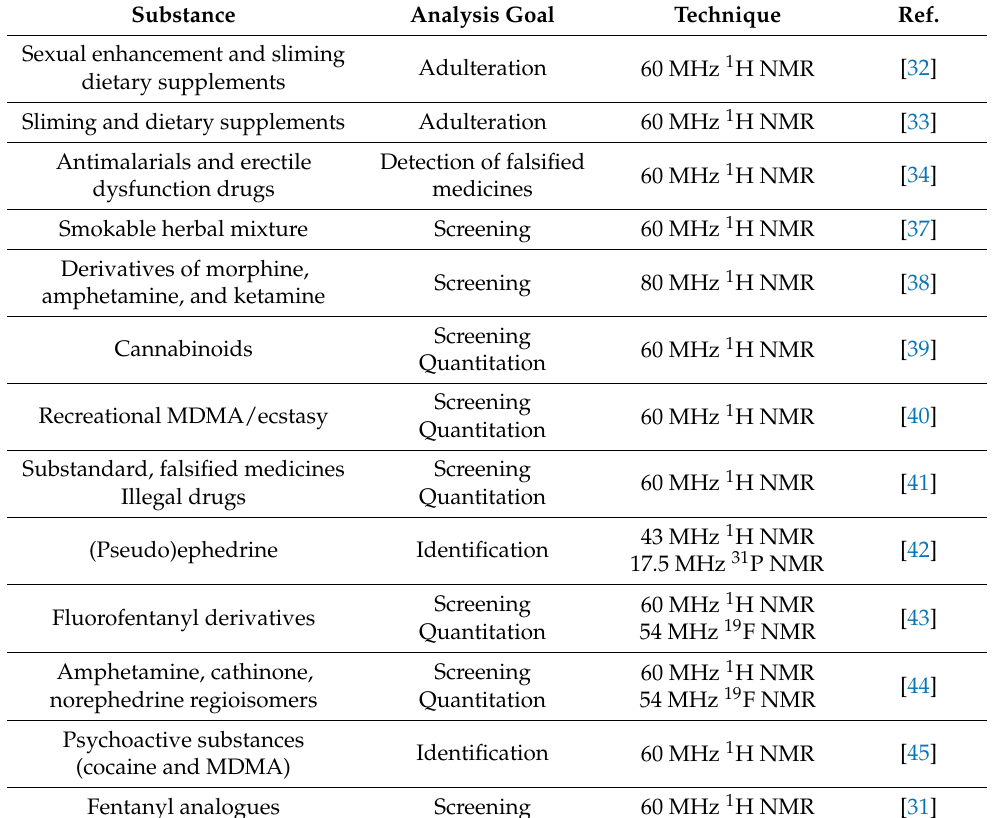
Table 2. Applications of benchtop NMR spectroscopy to the analyses of pharmaceuticals and